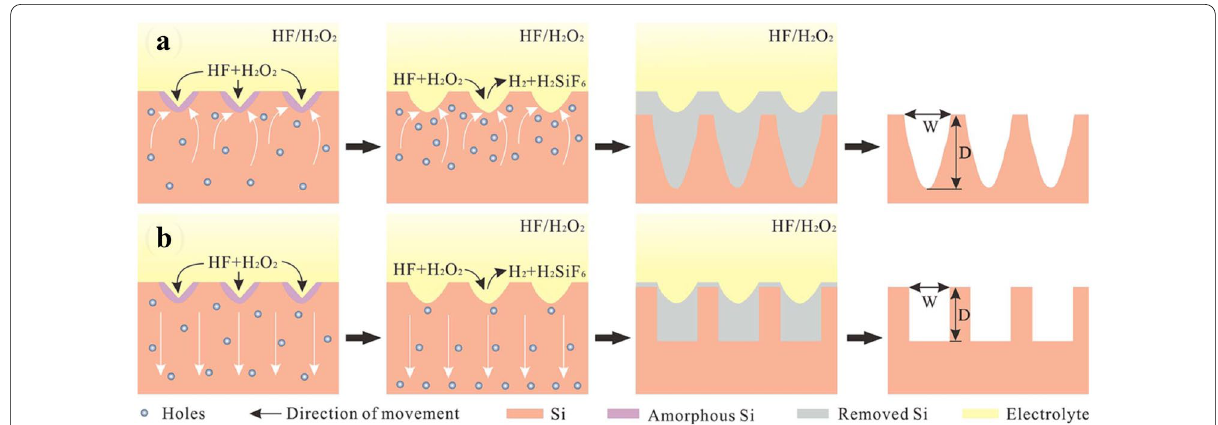
Figure 25 Etching mechanism of scratched silicon surface when the etching process applied with ( a ) positive voltage and ( b ) negative voltage in HF/H 2 O 2 solution